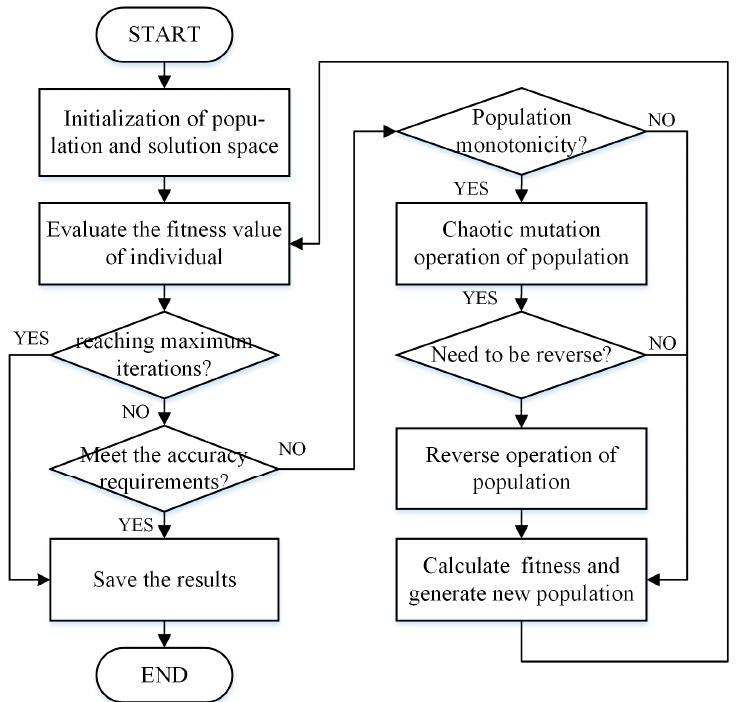
Figure 7. The process of the least squares support vector machine algorithm (LSSVM) parameter optimization by chaos estimation of distributed algorithm (CEDA).